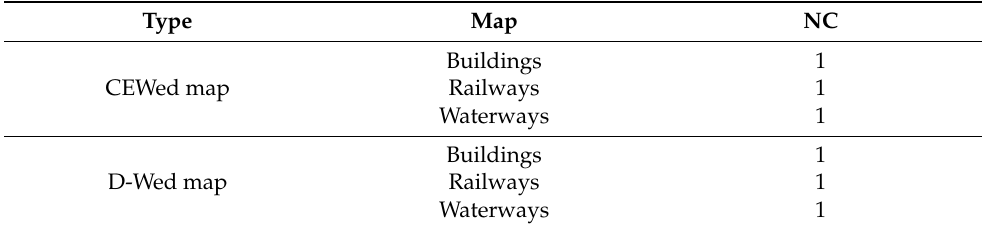
Table 4. The NC value of the extracted